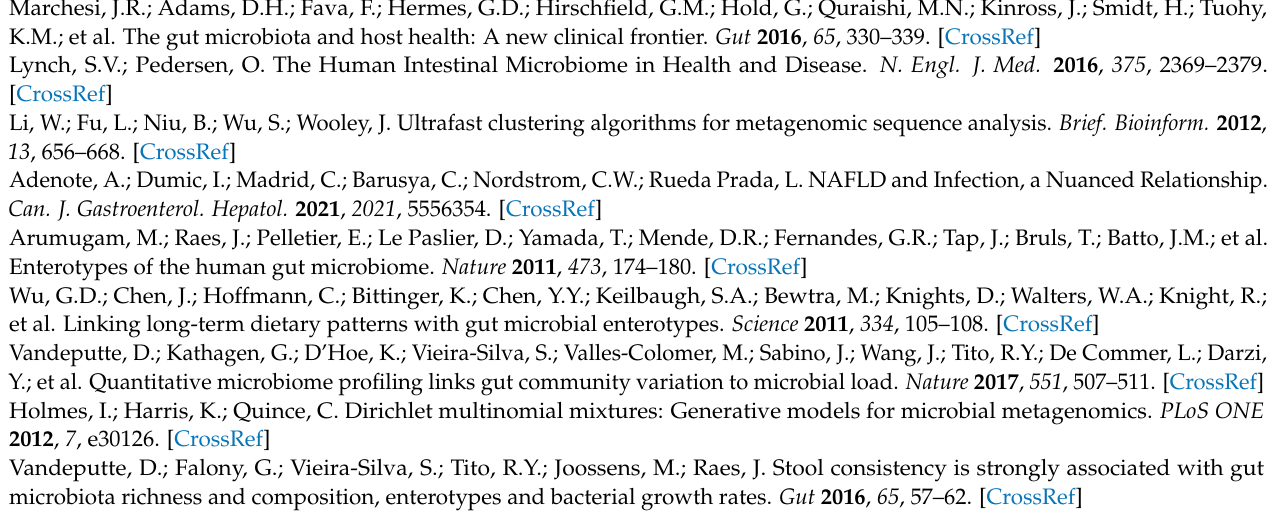
types; Supplementary Figure S5: Odds ratios of various diseases in each of the 15 DMM-model- identified community types; Supplementary Figure S6: α -diversity and principal coordinate analysis (PCoA) plots of gut microbiota for 15 community types stratified based on the Dirichlet multinominal mixtures (DMM) model